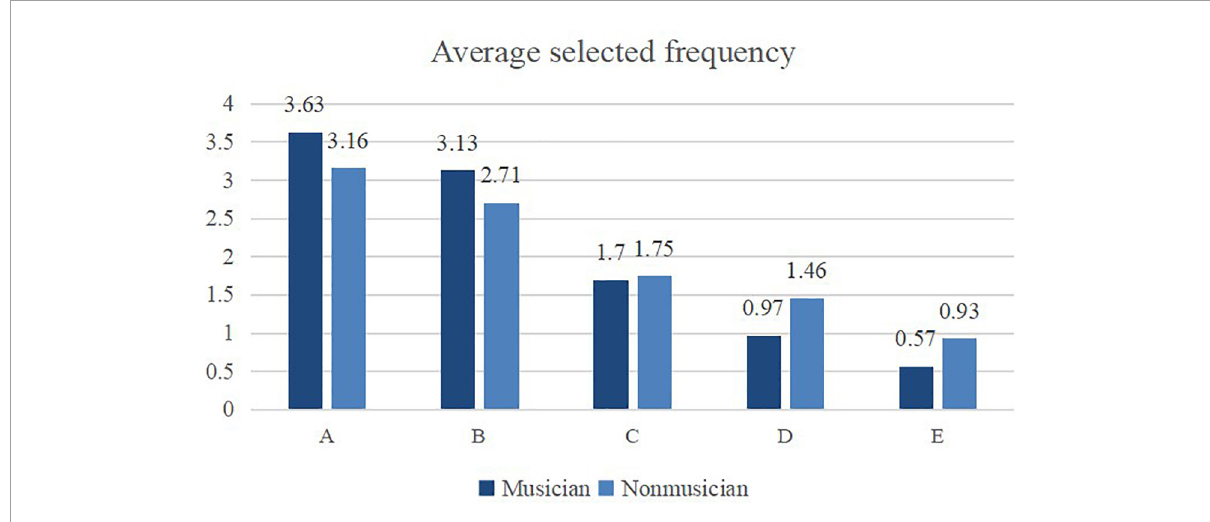
FIGURE4 Frequency statistics of audio material preference analysis of musician and nonmusician